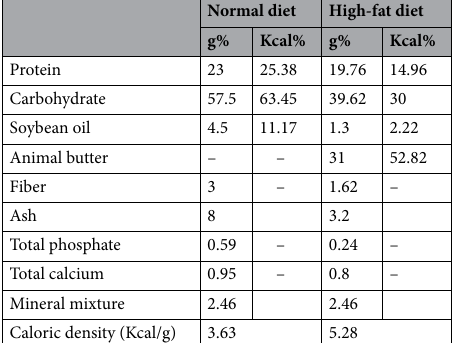
parameters 94 . Blood samples were collected in 1.5 mL Eppendorf tubes containing 10 µL/mL heparin (5000 IU/ mL, Caspian Tamin, Rasht, Iran) and centrifuged at 664× g for 10 min. Subsequently, plasma was removed and kept at − 70 °C until glucose, insulin, leptin, and corticosterone levels were measured. HOMA-β% = (20 × fasting insulin (µU/mL)/fasting glucose (mM)-3.5).